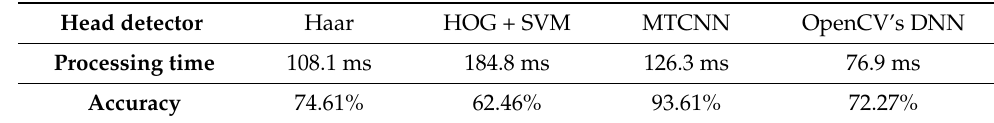
Table 3. Comparison of the time needed to process a single image frame.